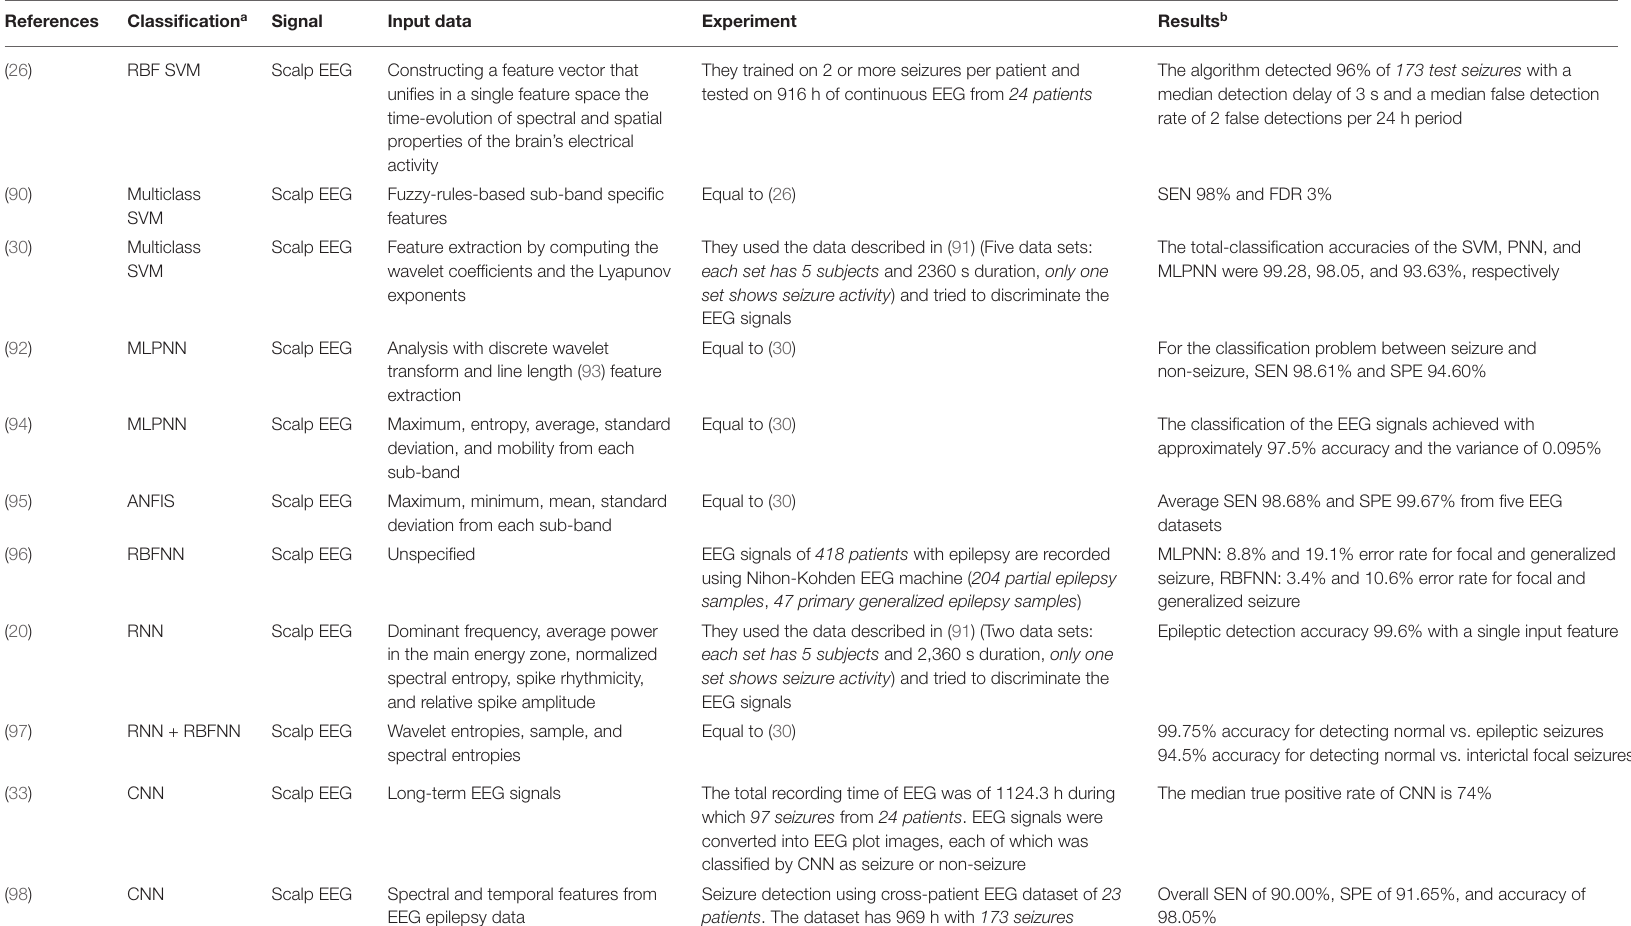
TABLE 2 | Classification for seizure detection [recommended comprehensive analysis: (88,